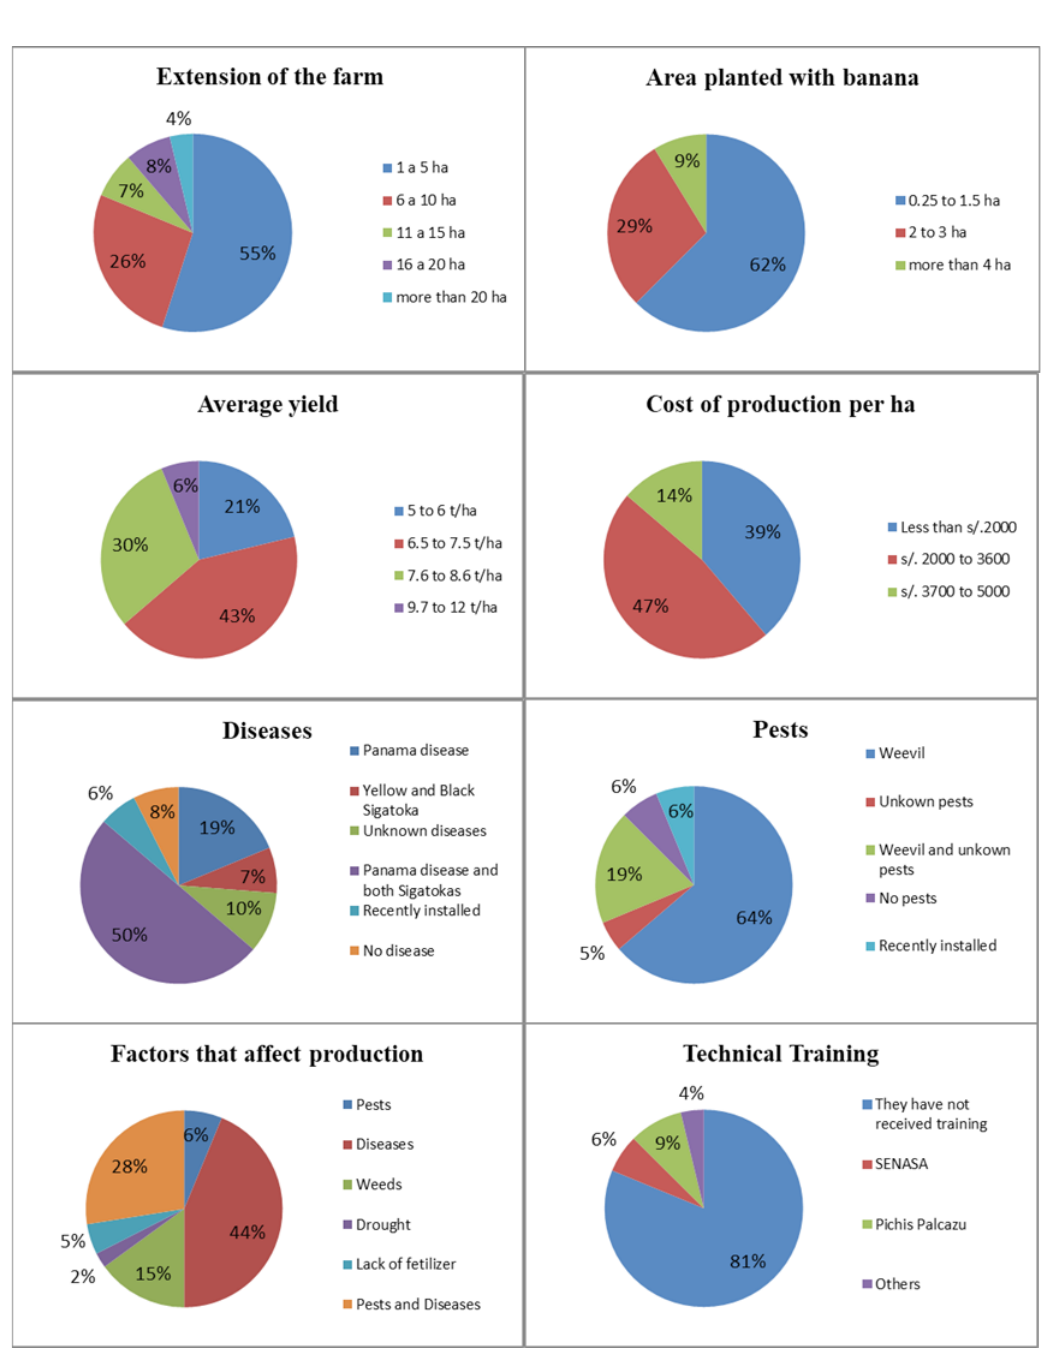
3. Characteristics of the production of the banana farm in the Cuyani Microbasin, Pichanaki